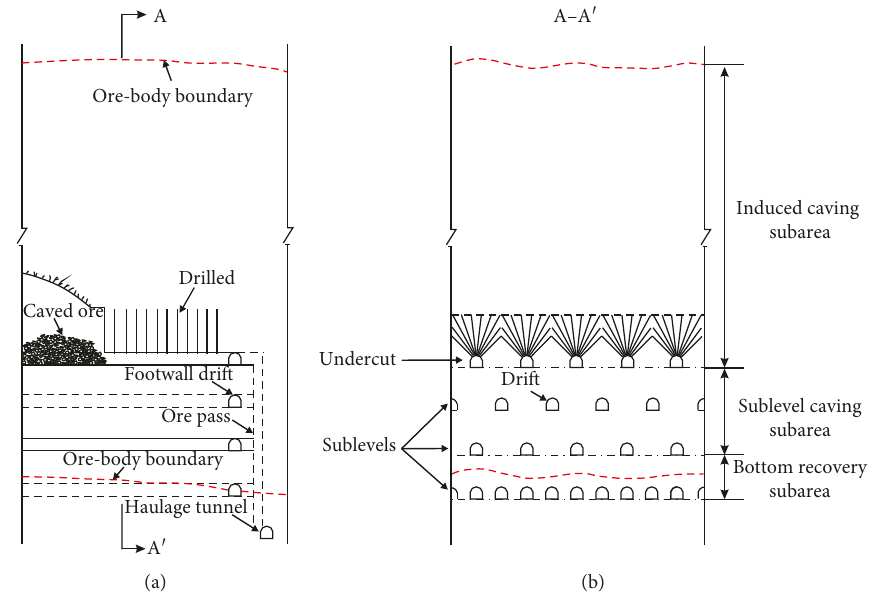
Figure 3: A typical induced caving mine